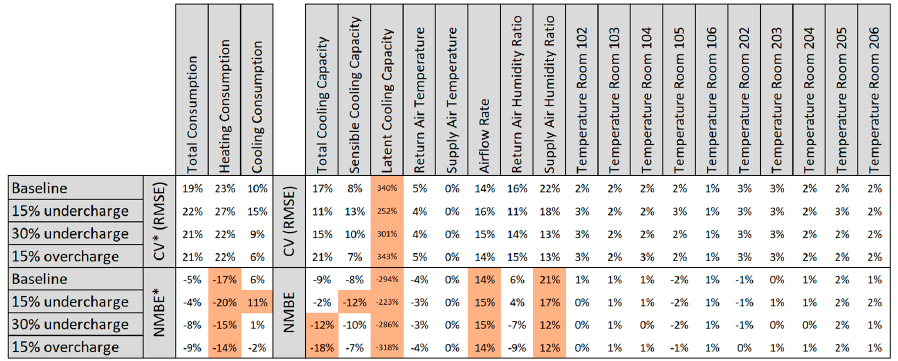
Buildings 2019 , 9 , x FOR PEER REVIEW 18 of 33